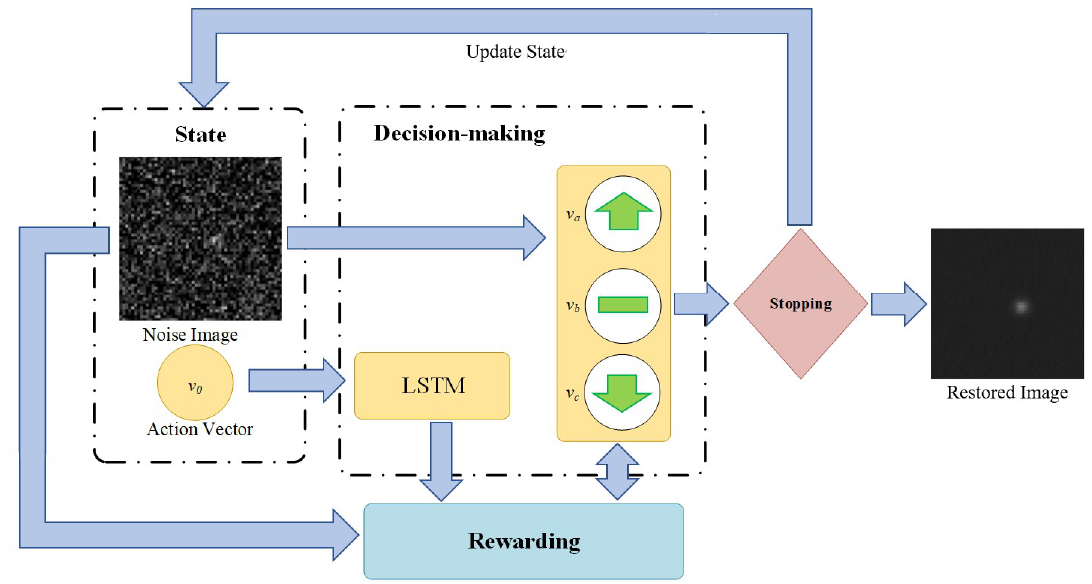
Figure 2. Flowchart of the star image denoising algorithm based on reinforcement learning.